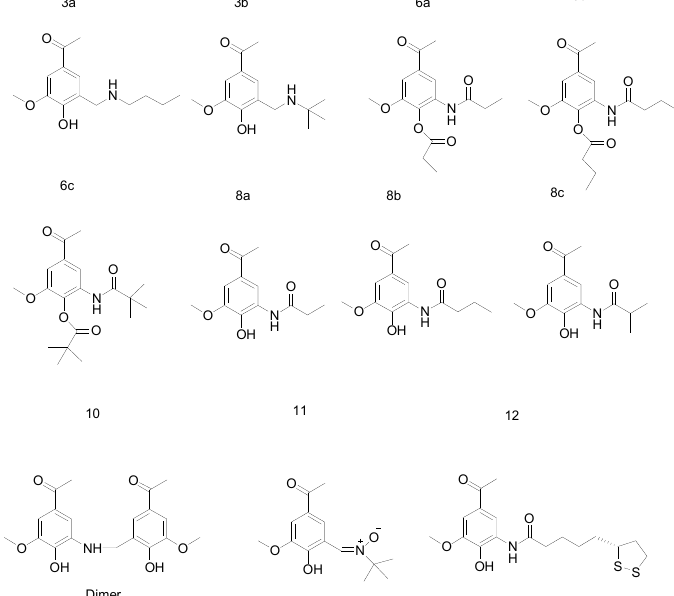
Figure 2. Apocynin analogues synthesized in our group as the test